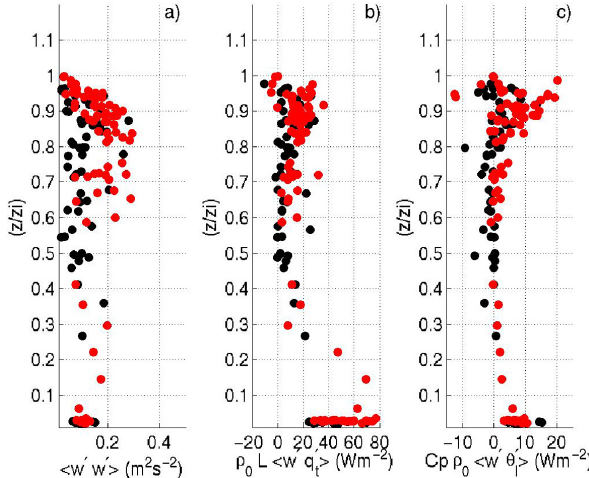
Fig. 8. (a) Vertical velocity variance (m 2 s − 2 ) , (b) total water flux (Wm − 2 ) , and (c) liquid water potential temperature flux (Wm − 2 ) vs. normalized height calculated from all the flight legs for the 18 flights. Red solid symbols (10 flights) are the typical well-mixed boundary layer, non-drizzling Sc discussed in Zheng et al. (2010), black solid symbols (8 flights) are the cases with complications in- volving strong wind shear within the BL, moist layers above the inversion, strong decoupled BL with cumulus below Sc.